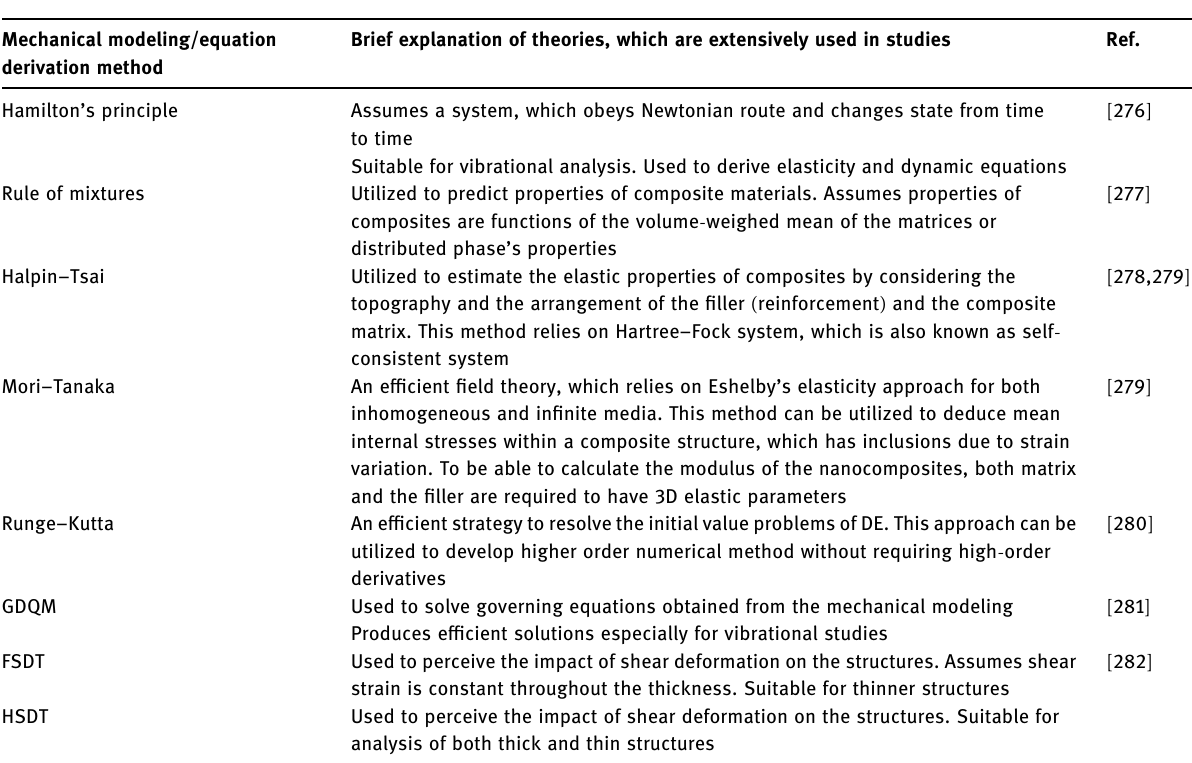
Table 24: Key assumptions and the main distinctions of mechanical